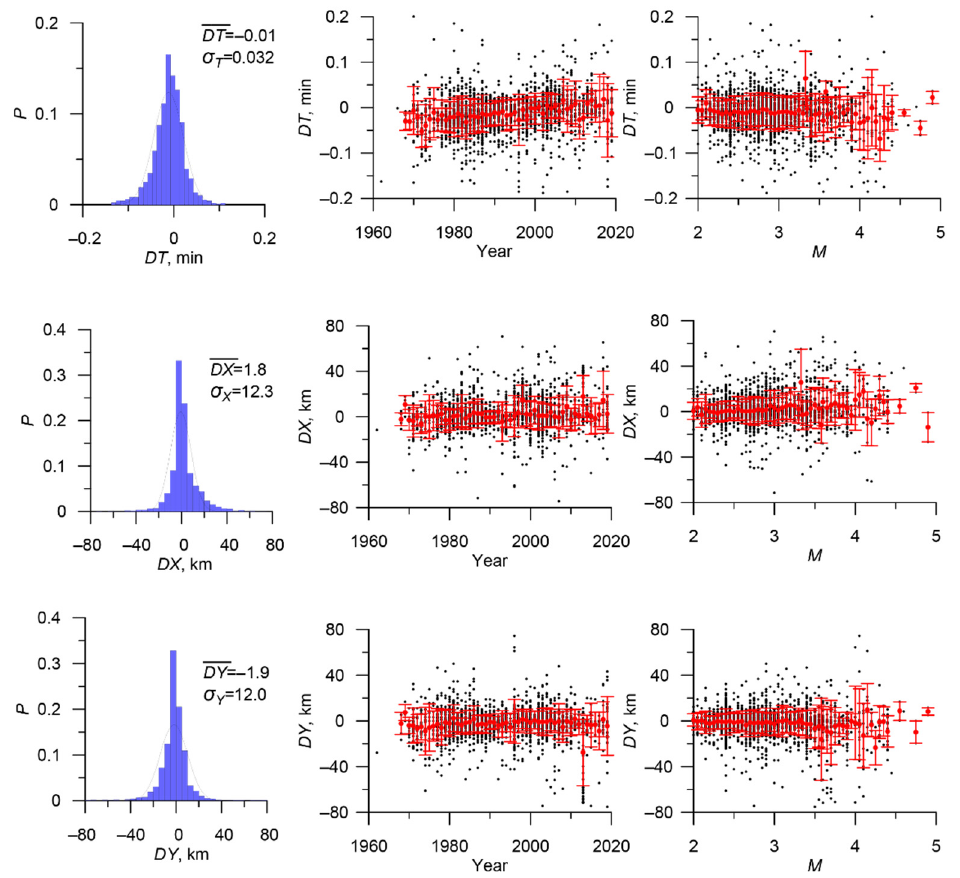
Figure 7. Distributions of DT, DX, and DY for the nearest events from the RUS and ISC_Other catalogs, and the dependence of the standard deviations σ T , σ X , and σ Y and the mean values DT , DX , and DY on the time and magnitude of the events. The red dots and bars are the population mean values and standard deviations,